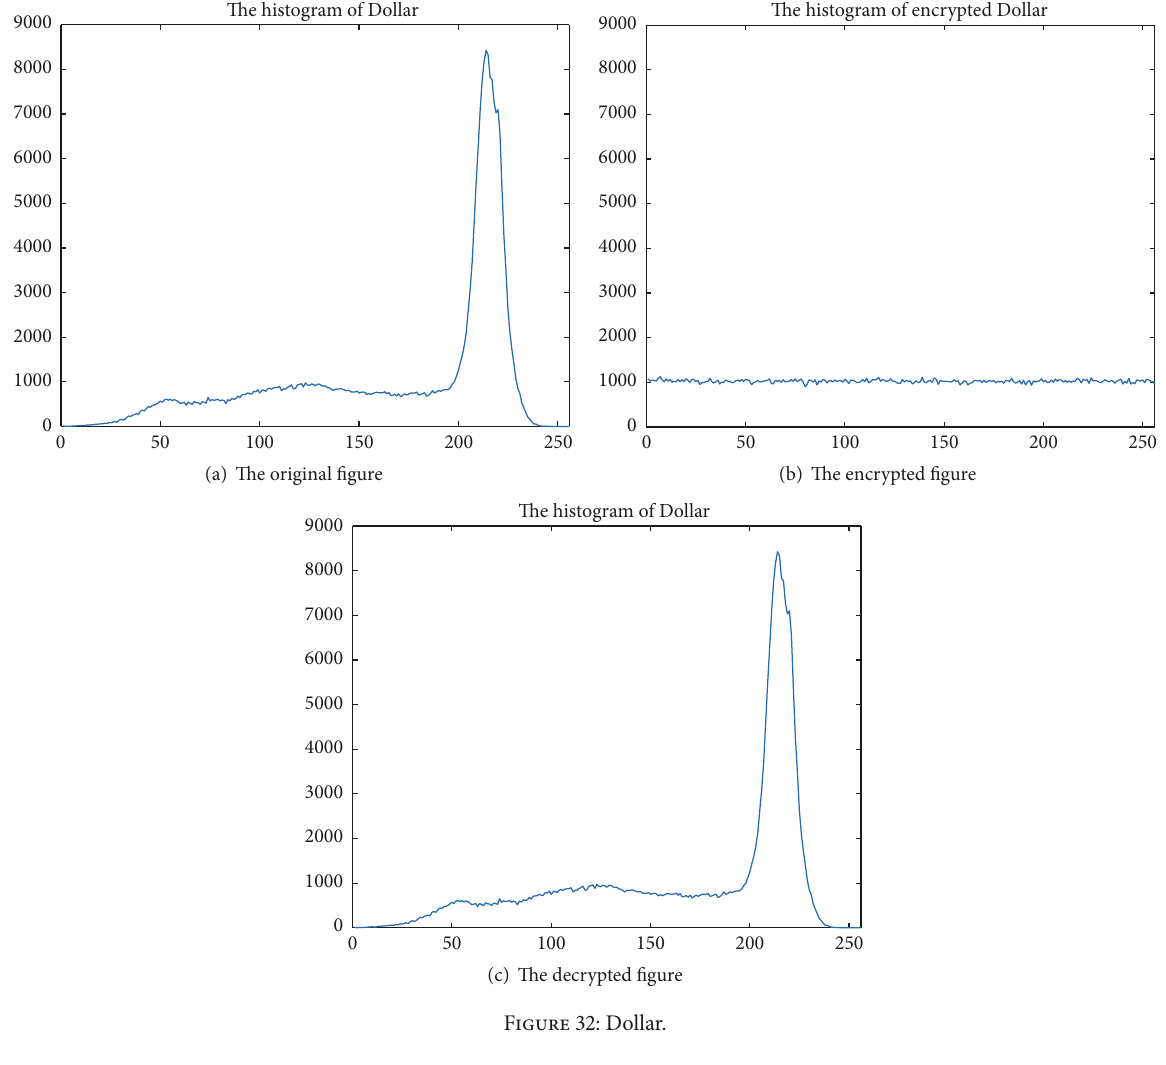
Table 9: NPCR and UACI between cipher-images with slightly different plain-images. Image